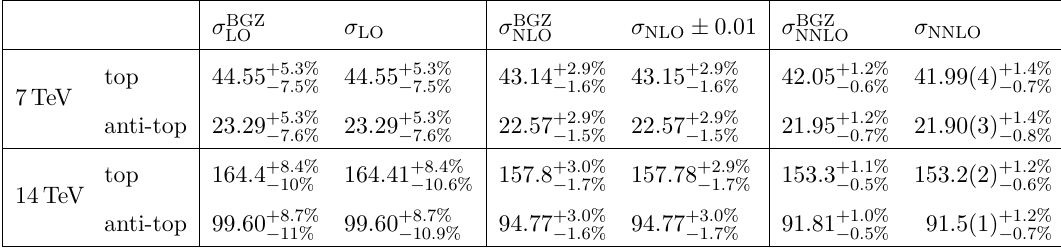
√ s = 13 TeV for comparison with BGZ , ref. [38]. The top-quark